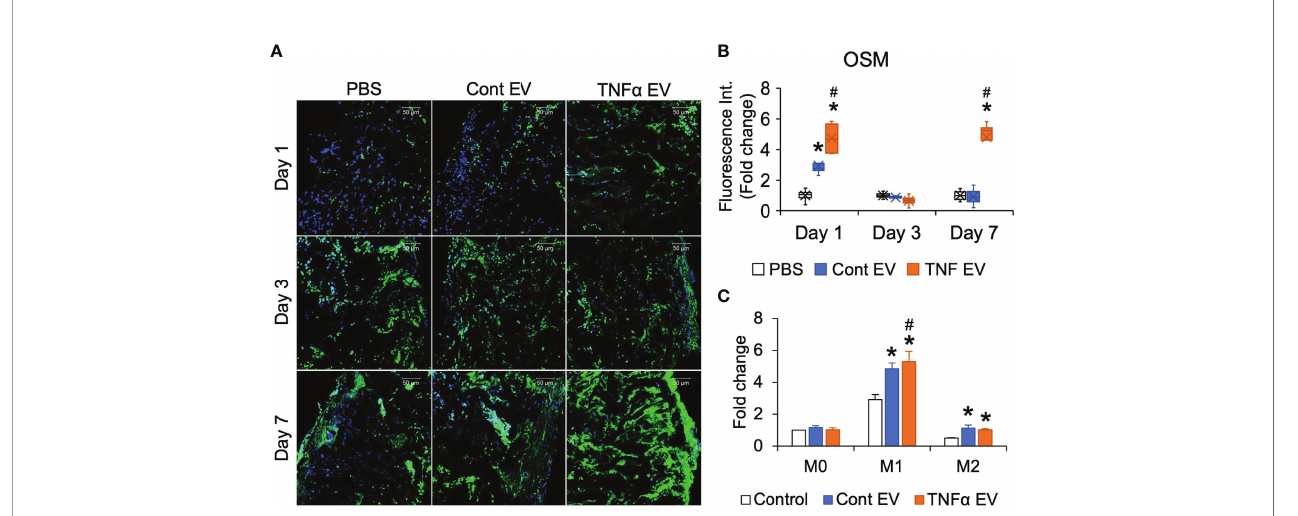
FIGURE 5 | OSM expression is in fl uenced by TNF a EVs. (A) Representative confocal micrographs of 1-, 3- and 7-day calvarial sections immunoassayed for OSM (green). Scale bar=50 m m in all images. (B) Image J based quantitation of fl uorescence intensity in tissue sections (n = 5). Data are presented as fold change in intensity with respect to untreated (PBS) controls. Note the signi fi cant increase in OSM intensity in the TNF a EV group compared to controls. *: statistical signi fi cance (P < 0.05) with respect to untreated control, #: statistical signi fi cance (P < 0.05) between control and TNF a EV groups as calculated by Tukey ’ s test post ANOVA. (C) Fold change in OSM expression in primary macrophages under naïve (M0), M1 and M2 polarization conditions in the presence/absence of control and TNF a EVs. Data are presented as fold change over M0 control (no EV) OSM expression. *: statistical signi fi cance (P < 0.05) with respect to no EV control in each polarization condition, #: statistical signi fi cance (P < 0.05) between control and TNF a EV groups as calculated by Tukey ’ s test post